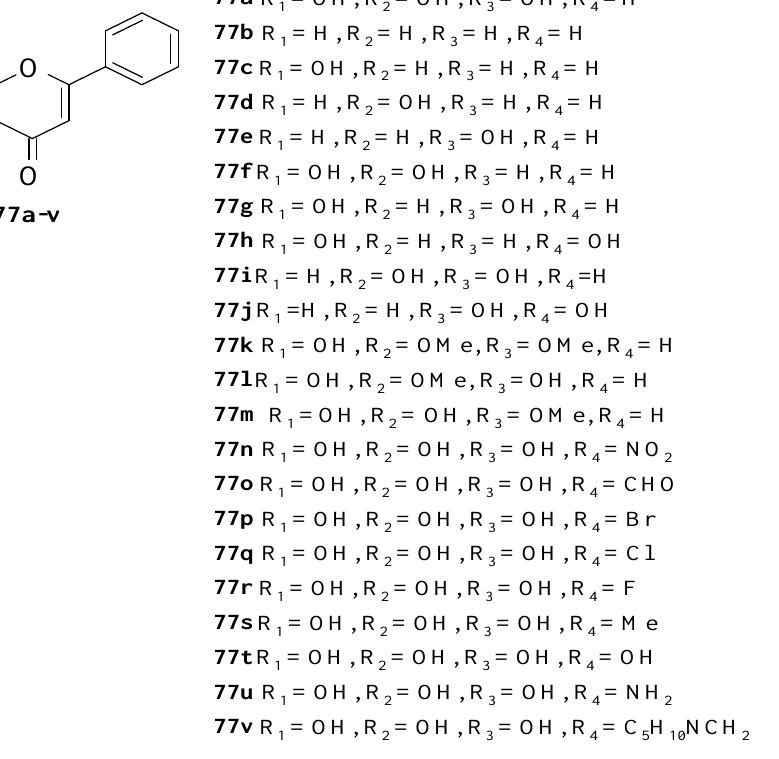
Figure 27. The chemical structures of synthesized flavone derivatives that were investigated for α -glucosidase inhibition [63].